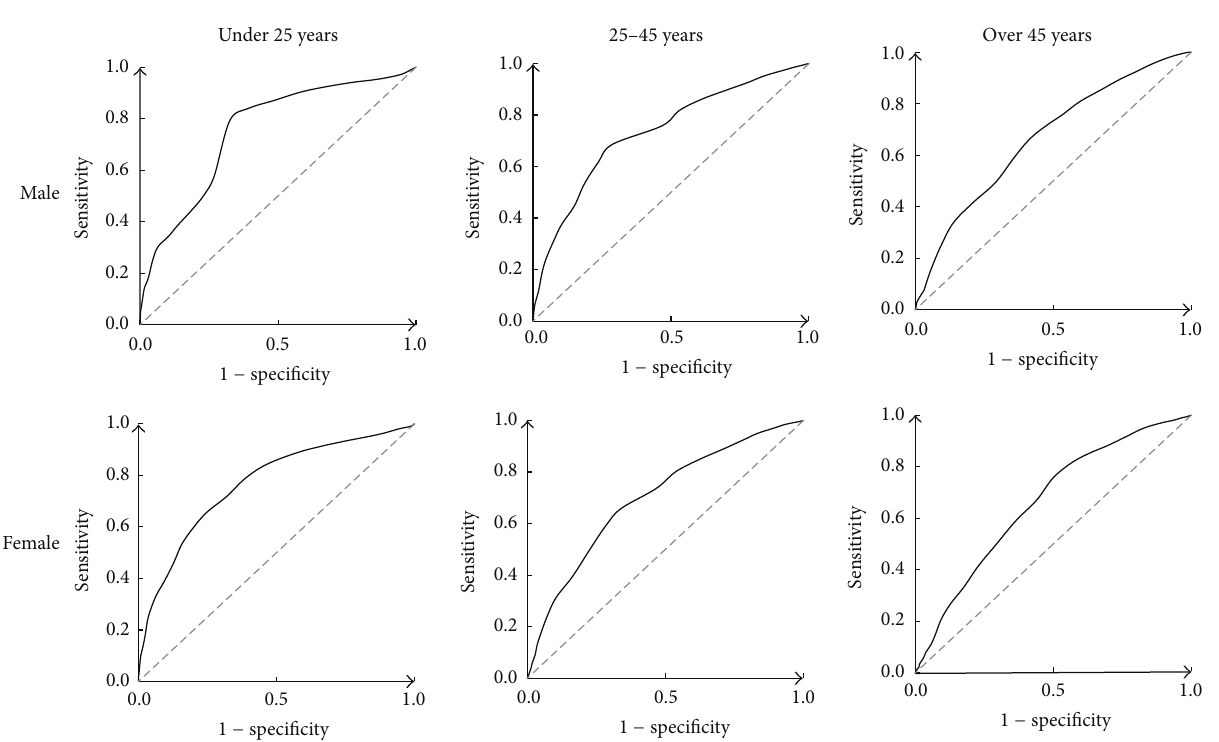
Figure 2: ROC curves of the McMonnies questionnaire in various gender and age groups. Note the relatively rounded curves (towards the upper left corner of the diagram) in younger subgroups, indicating good diagnostic performance.